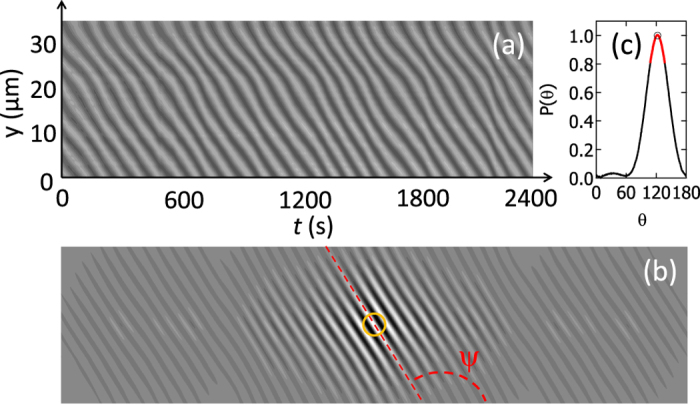
(a) Spatiotemporal diagram T(y, t) that results from projection over 20 min of the gray levels of all the pixels within the thin yellow rectangle pictured in Fig. 2(a) and oriented in the direction of the fringes displacement. (b) Auto-correlation function  of the spatiotemporal diagram T(y, t) pictured in (a). (c) Angular distribution P(θ) obtained from a radial integration of  inside a circular ROI of 50 pixel radius that is centered on the origin of the autocorrelation image [yellow circle pictured in (b)]. The fit of the angular distribution P(θ) by a Lorentzian function over an angular sector of 30° around the maximum [red curve in (c)] allows us to determine the tilt angle Ψ = 121.1° of the ridge line [red dashed line in (b)], and to compute the gel thinning rate v = 15.7 nm/s averaged over 20 min. Experiment conducted at the center of a 1.5% w/w agar gel cast in a plastic Petri dish made of PS.